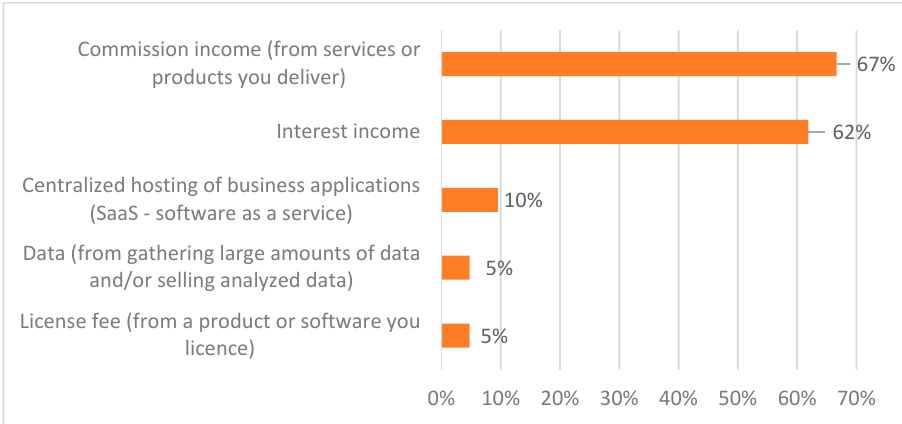
Figure 2. Revenue model (multiple responses allowed).